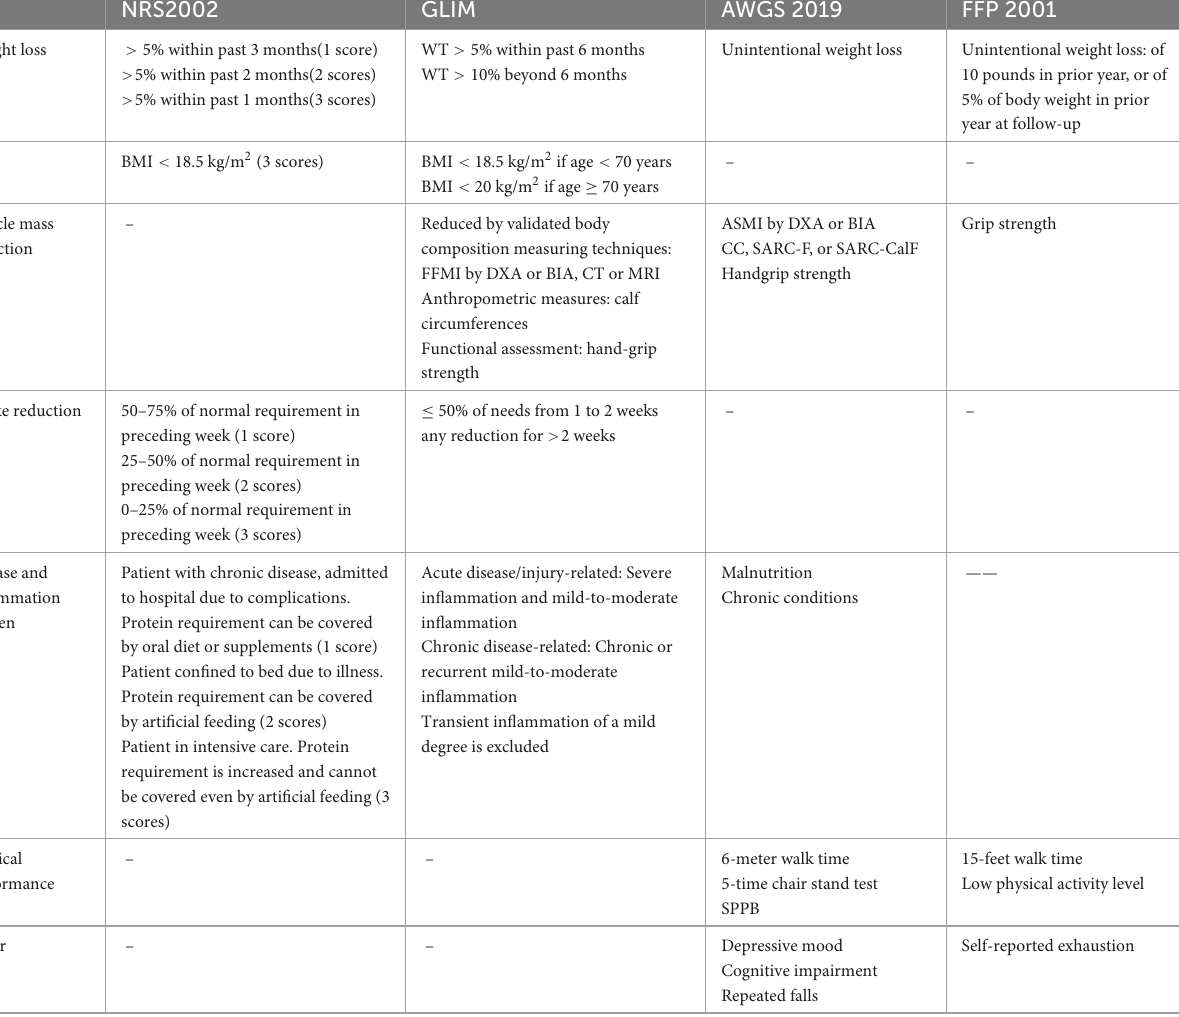
TABLE 1 Comparison of the four tools.